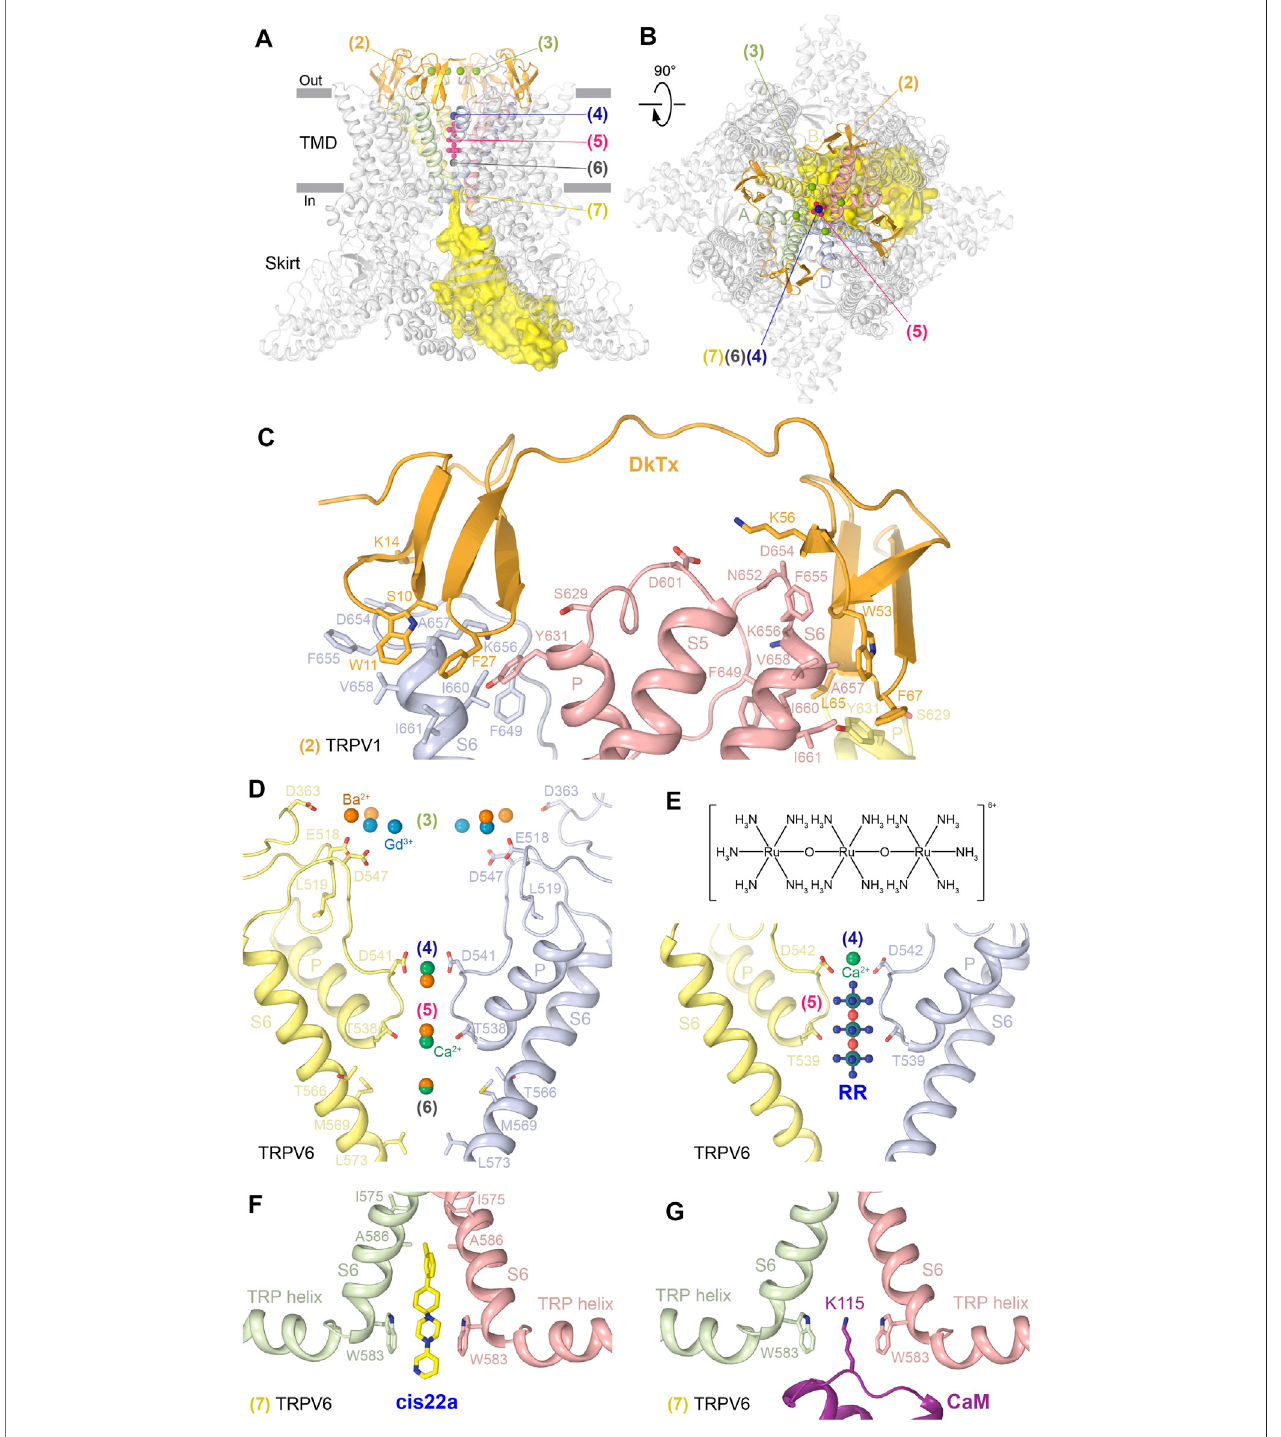
FIGURE 3 | Pore sites. (A – B) Side (A) and top (B) views of the TRPV1 tetramer (gray; PDB ID: 7LQY) with the DkTx (2), extracellular vestibule recruitment (3), extracellular pore entry (4), selectivity fi lter (5), central cavity (6), and intracellular pore entry (7) sites illustrated by ligands in orange, green, blue, pink, gray, and yellow, respectively. (C – G) Close-up views of the DkTx site in TRPV1 with bound DkTx ( C , PDB ID: 5IRX); extracellular vestibule recruitment, extracellular pore entry, selectivity fi lter, and central cavity sites in TRPV6 (D) with bound Ca 2+ (PDB ID: 5WO9), Ba 2+ (PDB ID: 5IWR), and Gd 3+ (PDB ID: 5WOA); extracellular pore entry and selectivity fi lter sites in TRPV6 with bound Ca 2+ and RR ( E , PDB ID: 7S8B); and intracellular pore entry sites in TRPV6 with bound cis22a ( F , PDB ID: 7K4B) or CaM ( G , PDB ID: 6E2F). Residues contributing to ligand binding are shown in sticks. The chemical structure of RR is shown above the corresponding close-up view (E) .